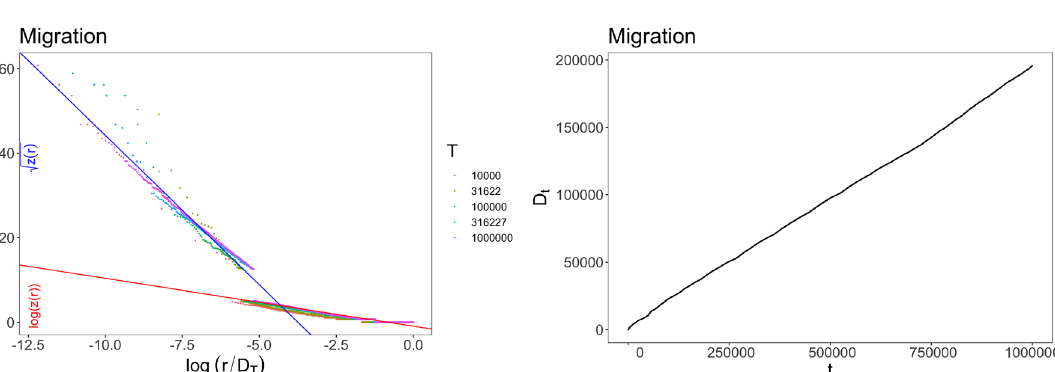
Figure 4. Migration: (Left) Frequency-rank plot in two different scales: log-sqrt before a certain R after R . Parameters (see Sections 3.3.1 and 3.4 for details): a 1 ∗ 1.13 and z 4 ( a 1 / a 2 ) 2 156.58 . The different colors of the dots correspond to different a 2 give ρ/ν = = = ∗ = quantities of data taken for depicting the plot. (Right) Behavior of D t